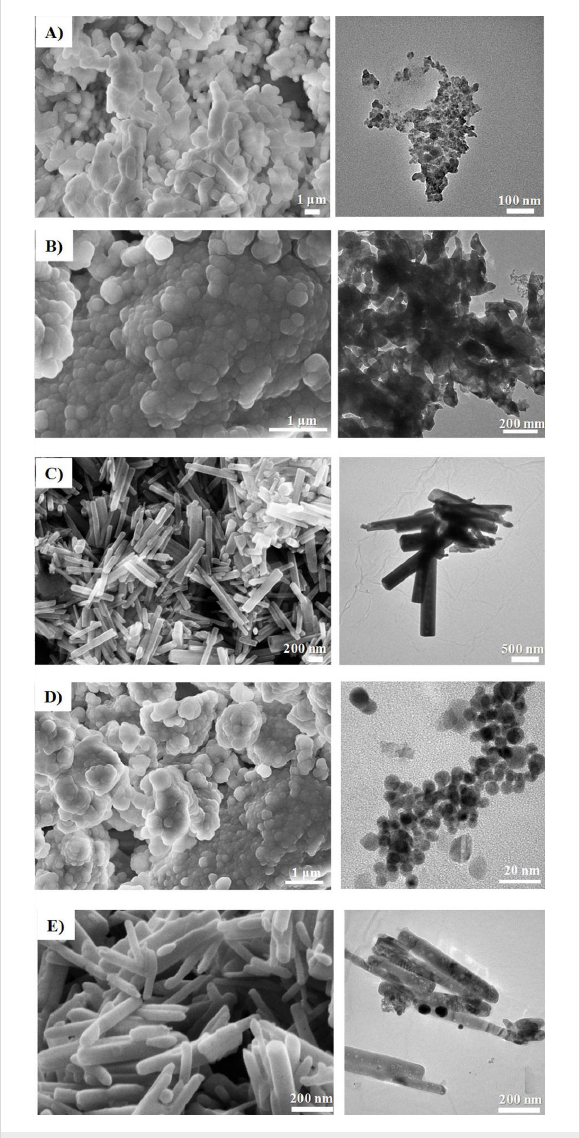
Figure 3: SEM (left side) and TEM (right side) images of ZnO A) dried at 120 °C, and annealed at B) 300 °C and C) 550 °C, and of Au@ZnO hybrid systems annealed at D) 300 °C and E) 550